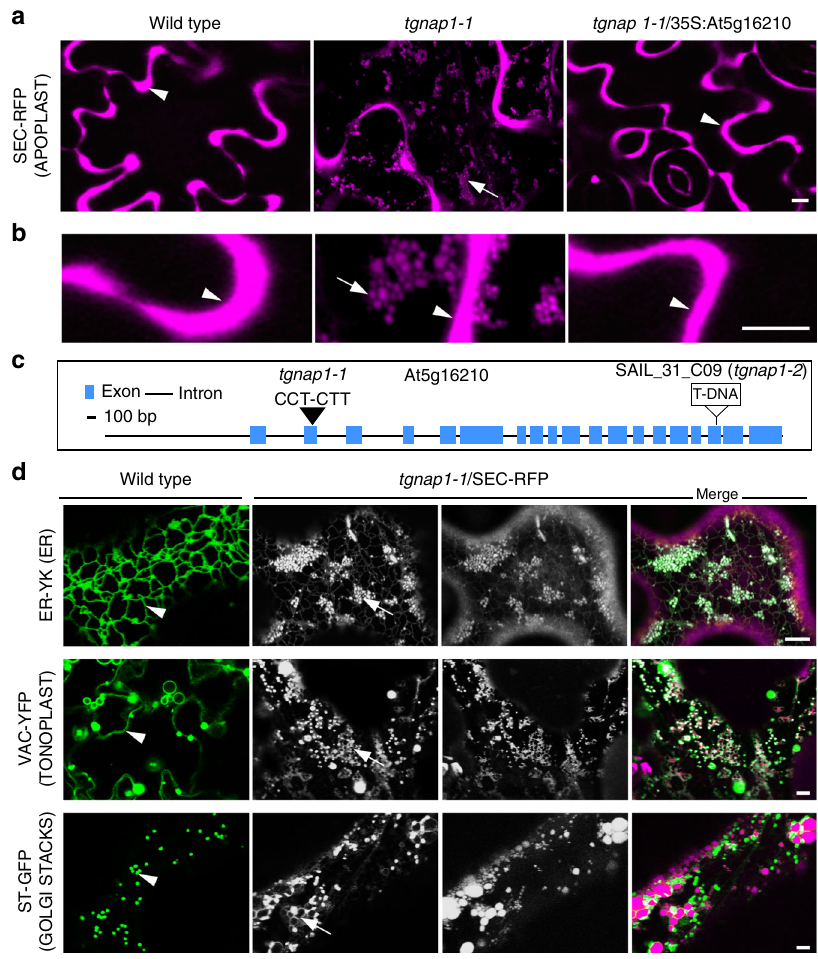
Fig. 1 Identi fi cation, subcellular phenotypes, and mapping of tgnap1 – 1 . a Live-cell confocal images of cotyledon epidermal cells SEC-RFP (magenta) showing distribution in the extracellular environment (apoplast, arrowheads) in WT and complemented tgnap1 – 1 , but partial retention in intracellular globular structures in tgnap1 – 1 (arrows). b Magni fi ed views of the cellular structures presented in a . c Genomic structure of TGNap1 ( At5g16210 ). d Confocal images of cells of WT and tgnap1 – 1 /SEC-RFP expressing markers for the ER network (arrowhead; ER-YK), vacuole membrane (arrowhead; VAC-YFP) and Golgi stacks (arrowhead; ST-GFP) (grayscale). Merged panels show in green and magenta, respectively, the endomembrane markers and SEC-RFP marker in tgnap1 – 1 . In tgnap1 – 1 , these markers are found also surrounding the aberrant SEC-RFP structures indicated by arrows. Scale bars = 5 µ